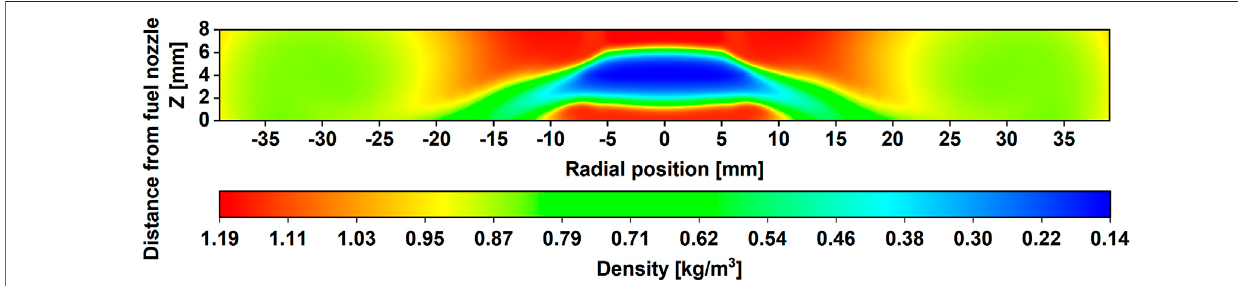
FIGURE 5 | Density contour in counter fl ow diffusion fl ame.